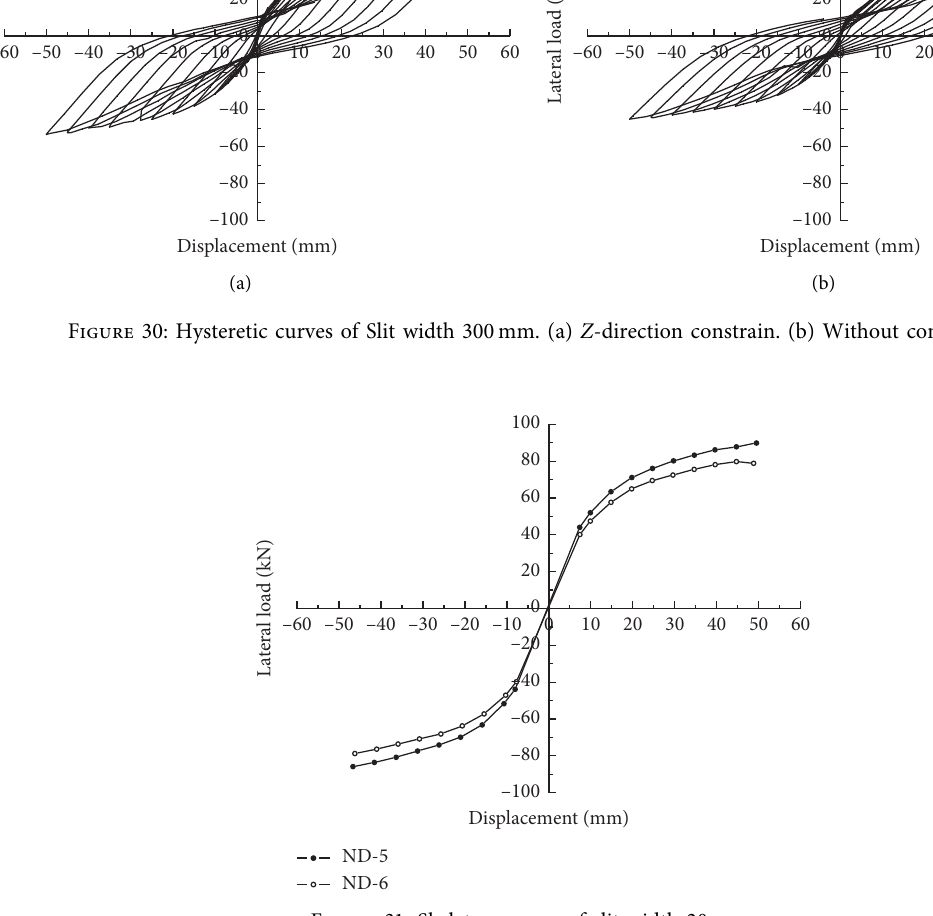
Figure 31: Skeleton curves of slit width